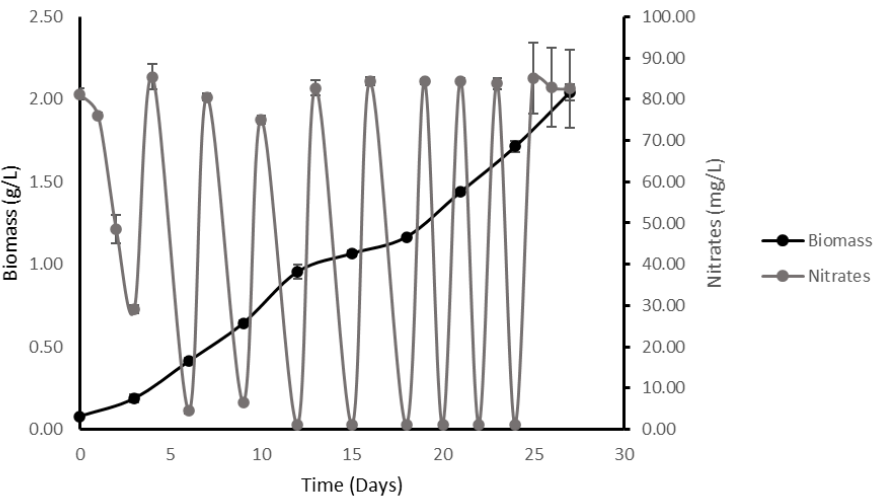
Figure 2. Growth kinetics of M. salina with excess nitrates. Culture supplemented by nitrate and phosphate pulses at 75 mg/L and 4.41 mg/L, respectively. The growth curve is expressed in dry microalgae biomass (g/L) and dissolved nitrates (mg/L) in culture as a function of time. The observed values for growth rate and substrate yield were approximately three times higher than the obtained when growing M. salina in a media containing conventional nitrate and phosphate concentrations (75 mg/L and 4.41 mg/L, respectively) but with a much lower specific growth rate of the process (4.99 × 10 − 3 ± 3.70 × 10 − 5 h − 1 ), as well as nitrate yield (2.63 g biomass/g nitrate). At the end of the experiment, which was set at 24 days of continuous nitrate feeding, the provided culture reaches a final nitrate concentration of 827 ± 7 mg/L, in which the residual concentration equals 83 ± 3 mg/L. These results indicate that M. salina, in the defined conditions, was able to consume 744 ± 4 mg of nitrate in one liter of